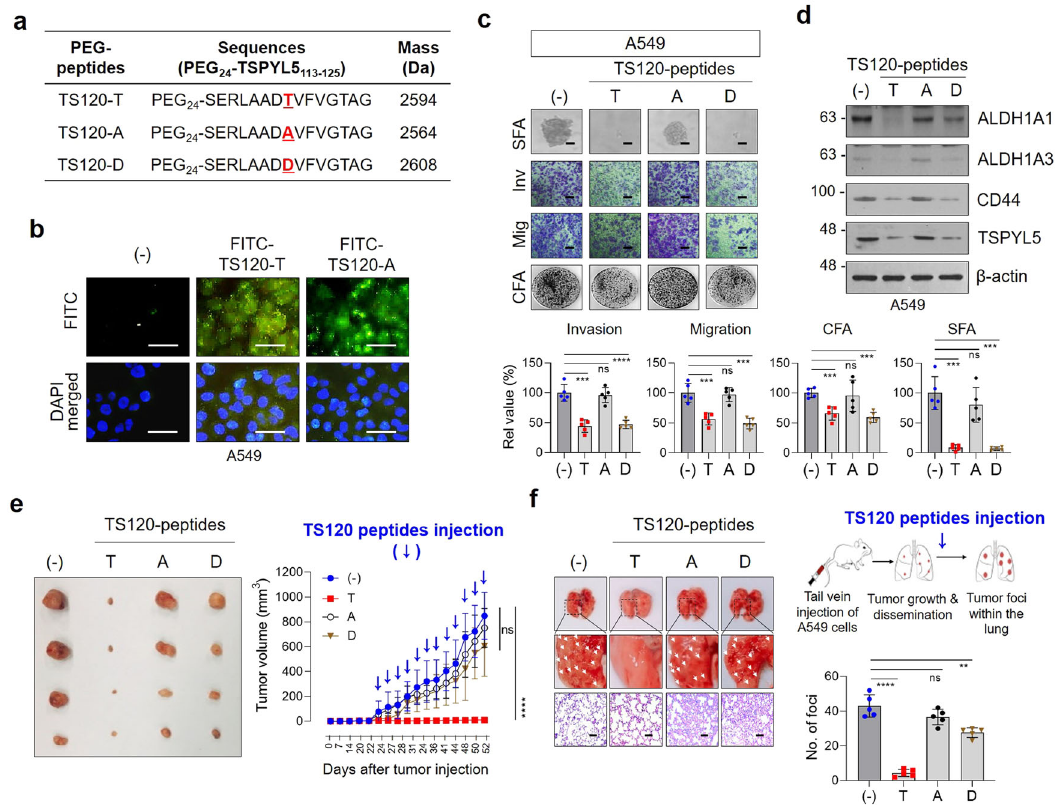
Fig. 8 Cell-permeable TSPYL5 peptide can block EMT and tumorigenicity in in vitro and in vivo systems. a Sequences of cell-permeable PEGylated TS120 peptides. b Cell permeability of FITC-labeled TS120 peptides (FITC-TS120-T and FITC-TS120-A) into the cells shown by fl uorescence microscopy. A549 cells attached on coverslips were incubated with FITC-labeled TS120 peptides. c TS120 peptides affect metastatic capacity (invasion/migration), sphere-formation ability (SFA), and colony-formation ability (CFA) of A549 cells . n = 5 independent experiments. Scale bar: 20 μ m. d Effects of TS120 peptides on the cellular level of TSPYL5, ALDH1, and CD44. Peptides were treated at a concentration of 10 μ M for 12 h. e Effects of TS120 peptides on tumorigenic capacity of ALDH1 high -A549 cells in vivo. ALDH1 high cells (1 × 10 6 ) sorted from A549 cells were subcutaneously injected to athymic BALB/c female nude mice ( n = 4 per group). After tumor formation (13.4 mm 3 , 3 weeks after injection), TS120 peptides were intratumorally injected twelve times at 2-day intervals (one injection dose was 40 μ g; total 480 μ g). Tumor size was measured every two or three days, and the volume was calculated by shortest diameter 2 × longest diameter 2 . Tumor burdens were removed from mice after 8 weeks of cell injections and photographed. g Effects of TS120 peptides on metastatic dissemination of ALDH1 high -A549 cells in vivo. Peptides were fi rst administered at 4 days after intravenous injection of ALDH1 high - A549 cells into BALB/c nude mice (5 weeks of age, n = 5 per group). TS120 peptides were then treated twelve times every other day by intravenous injection (40 μ g/dose/mouse; total 480 μ g). The white arrow indicates the metastatic foci in the lung and the number of metastatic foci per lung was plotted. Representative images of H&E-stained lung sections show tumor foci. Data represent mean ± s.d. using two-tailed t -test. NS not signi fi cant, ** p < 0.01, *** p < 0.001 , **** p <